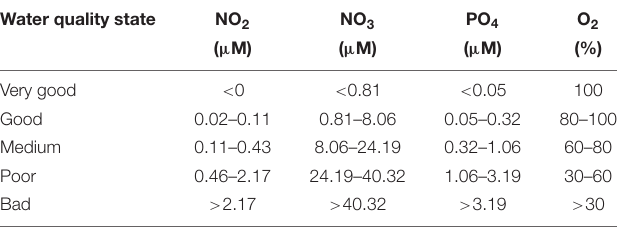
were more widespread in February 2020 than in February 2019 ( Table 2